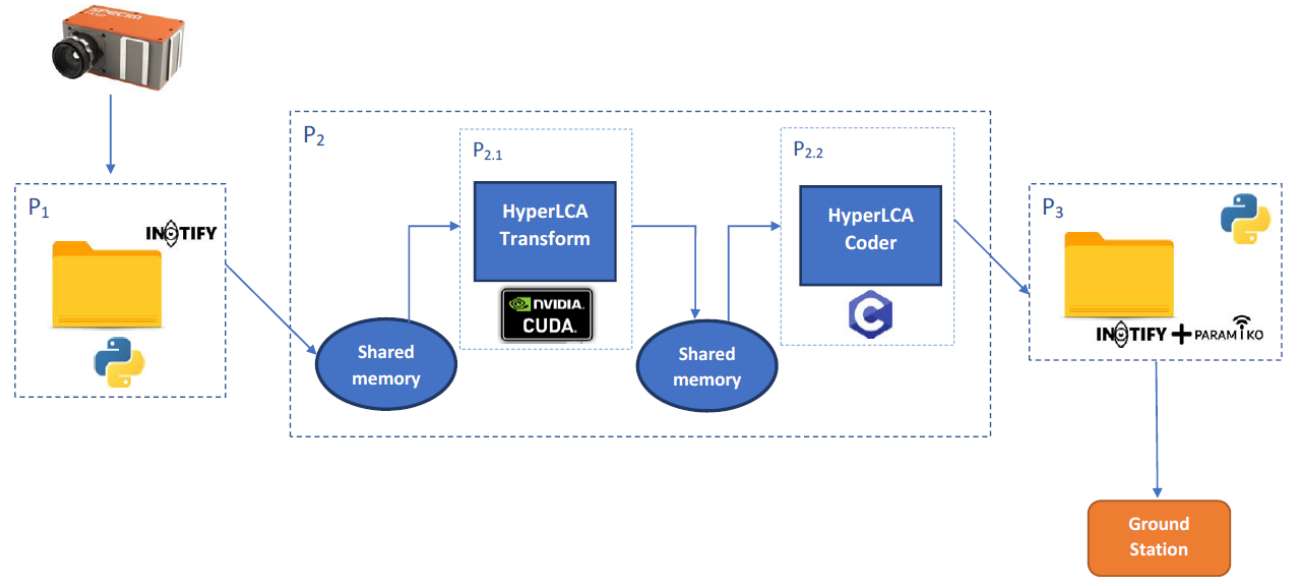
Figure 5. Proposed design for the real-time compression and transmission of the hyperspectral